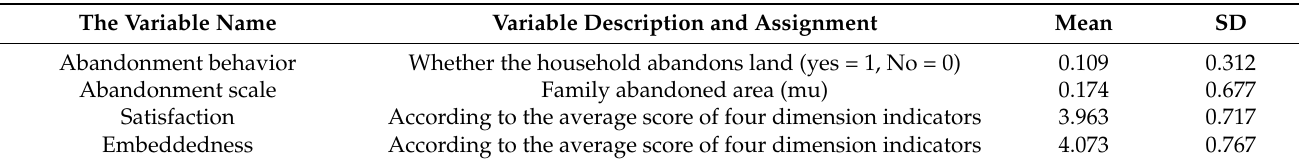
Table 1. Variable description and descriptive